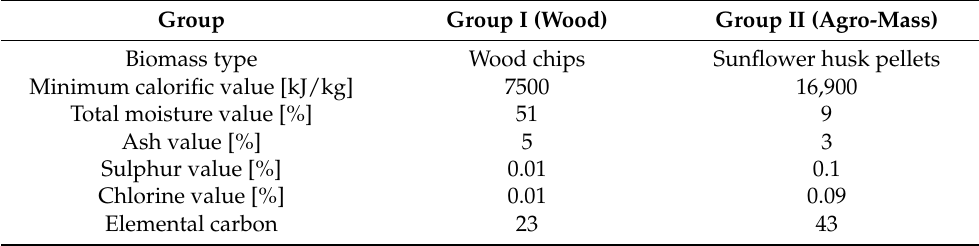
Table 1. Quality parameters of biomass currently burned at the power plant in Southern Poland.